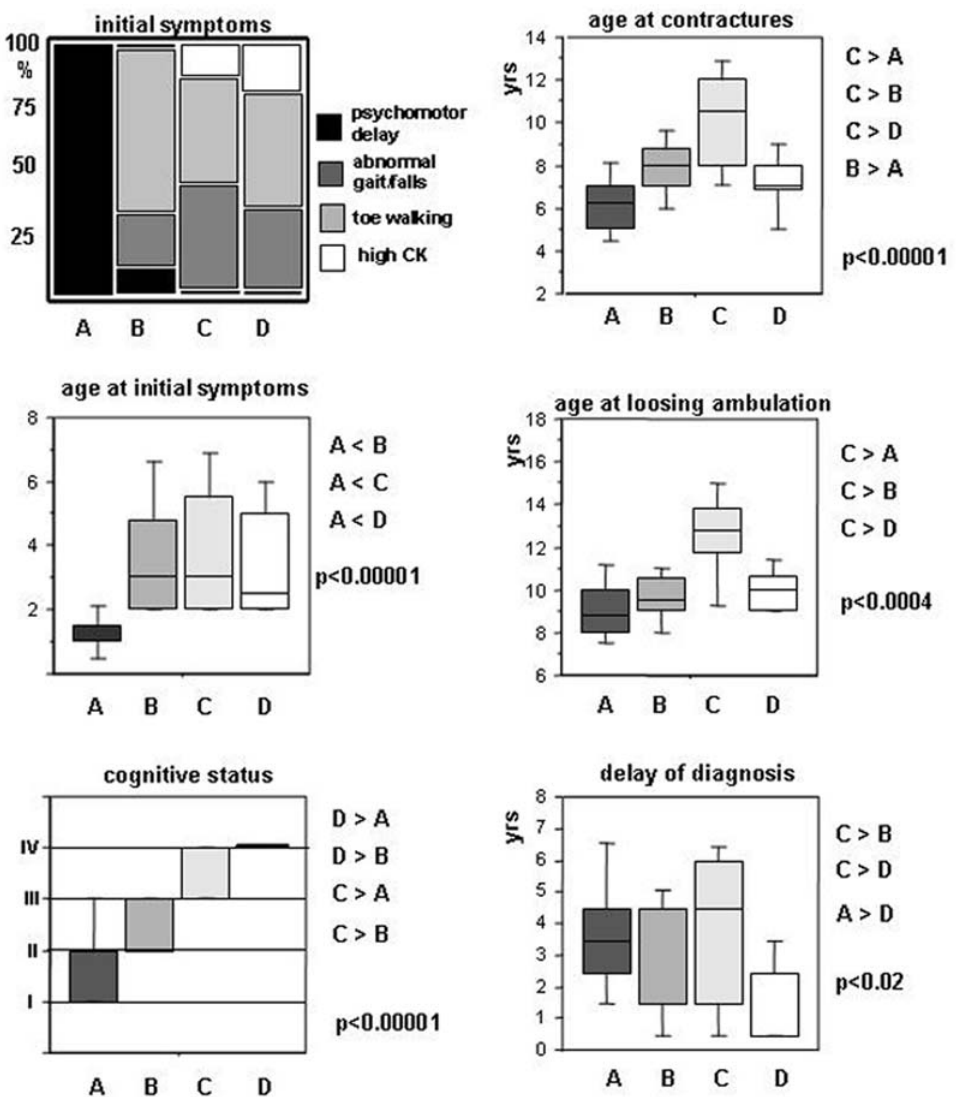
severely mentally retarded; (II) mildly mentally retarded; (III) borderline; (IV) normal). This was also supported by an identical increase of ‘‘maximal education level’’ and an inversely symmetrical decrease of ‘‘school delay’’ (p , 0.00001 for both, data not shown). Accordingly, 86% of D patients attended an ordinary educational establishment vs. 38% of C, 26% of B and 21% of A patients (all p , 0.007 by Fischer exact test). A and C patients had values at each extremity of the motor function spectrum, also comprising the age of becoming ‘‘wheelchair-ridden’’ (p , 0.00001, not shown).